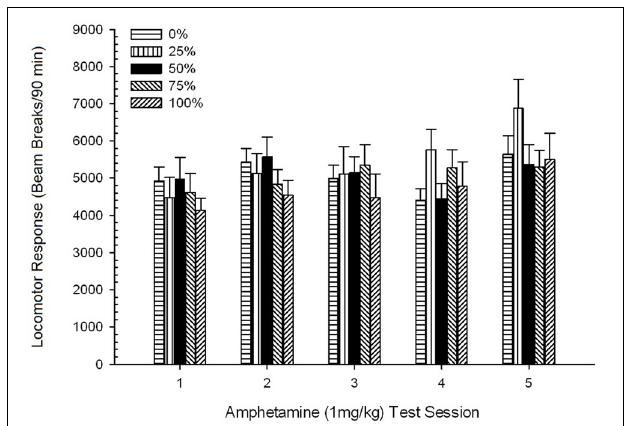
FIGURE 6 | Mean (SE) locomotor response (number of beam breaks in an electronic array per 90min) to 1mg/kg d-amphetamine (i.p.) on 5 weekly sessions in groups of Sprague Dawley rats ( n = 8/ group) previously exposed to 15 daily conditioning sessions with sucrose reward (10% solution) delivered under 0, 25, 50, 75, or 100% variable schedules. The conditioned stimulus was a light (120s). Group 0 received the same number of rewards as group 100 in the absence of conditioned